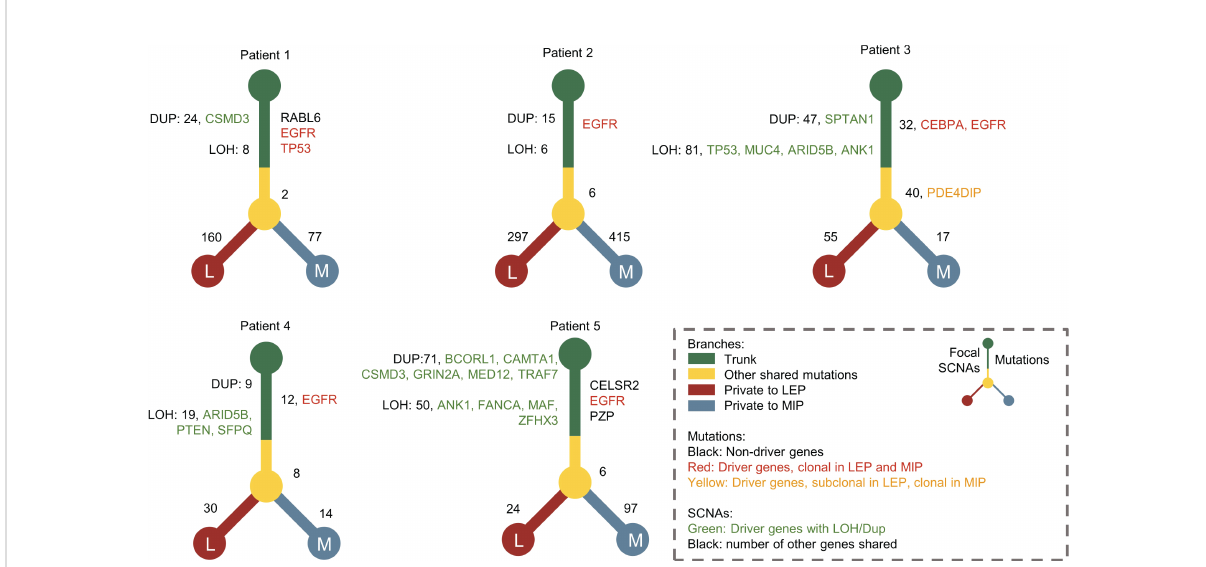
FIGURE 3 The phylogenetic trees constructed for patients with concomitant MIP and LEP components. Driver genes with mutations and focal CNV were marked with different colors. The numbers of shared mutations and focal CNVs were labeled beside the tree trunk, while mutation numbers private to MIP and LEP components were labeled beside the tree